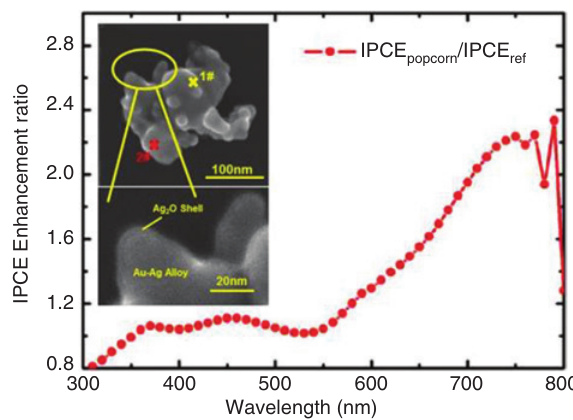
Figure 18: The IPCE enhancement ratio of the plasmonic DSCs. IPCE enhancement ratio = IPCE /IPCE where IPCE and popcorn( λ ) TiO 2 -only( λ ), popcorn( λ ) IPCE are the IPCEs of the popcorn NP-enhanced DSCs and TiO 2 -only( λ ) TiO -only DSCs at wavelength λ , respectively. Scanning electron 2 microscopy (SEM) images of popcorn NPs are shown in inset.